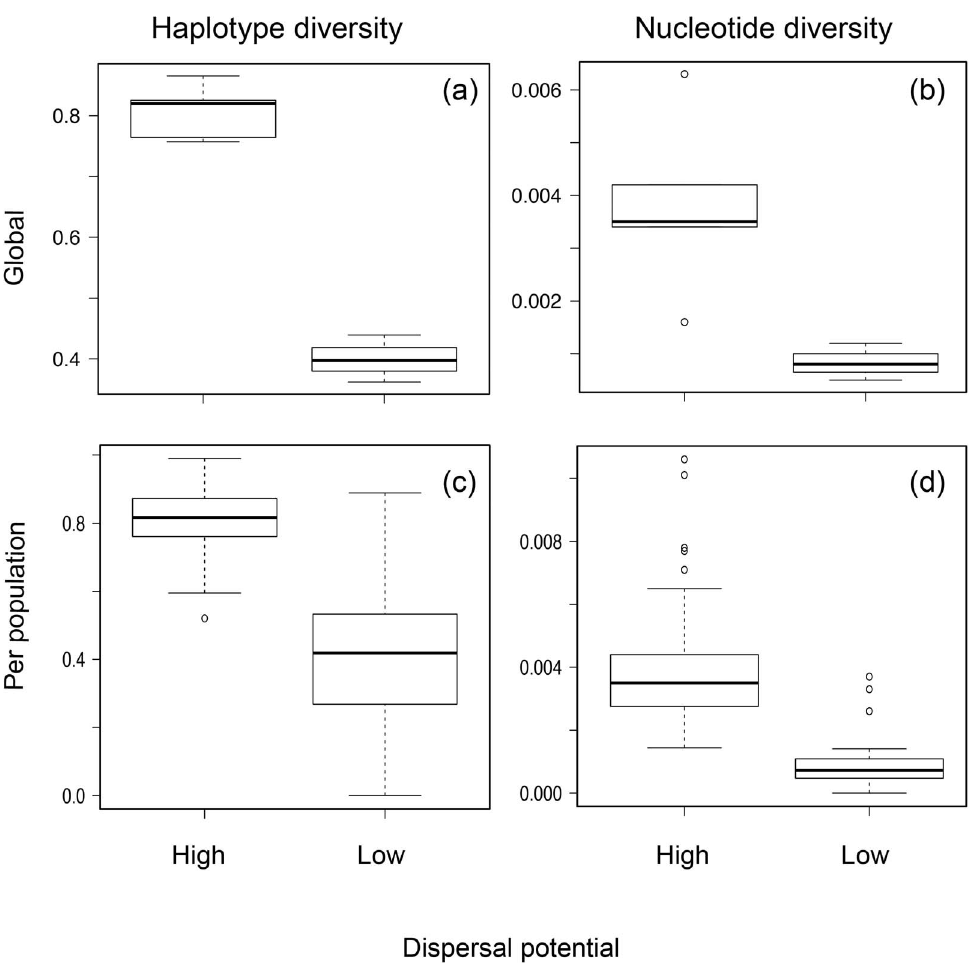
Figure 2. Box-plots of global (a and b) and per population (c and d) haplotype (a and c) and nucleotide (b and d) diversities for high and low dispersers.